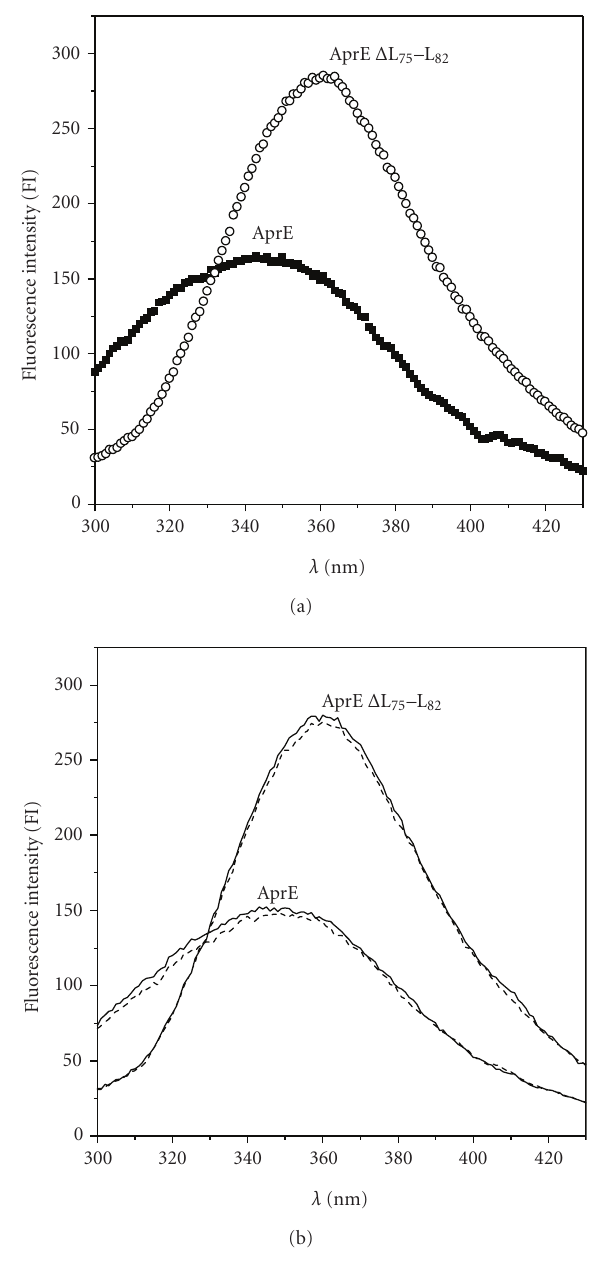
Figure 2: (a) Emission spectra of wild-type AprE and AprE Δ L 75 –L 82 . (Solid squares) wild-type AprE, (Open circles) AprE Δ L 75 –L 82 . (b) Emission spectra of wild-type AprE and AprE Δ L 75 –L 82 in the presence of 0.5mM EGTA . (Continuous line) native state; (Dashed line) 0.5mM EGTA. Assays were performed on 10mM Pipes, pH 7.5 bu ff er at room temperature (25 ◦ C) using a 1cm cuvette of 1.5 mL with continuous